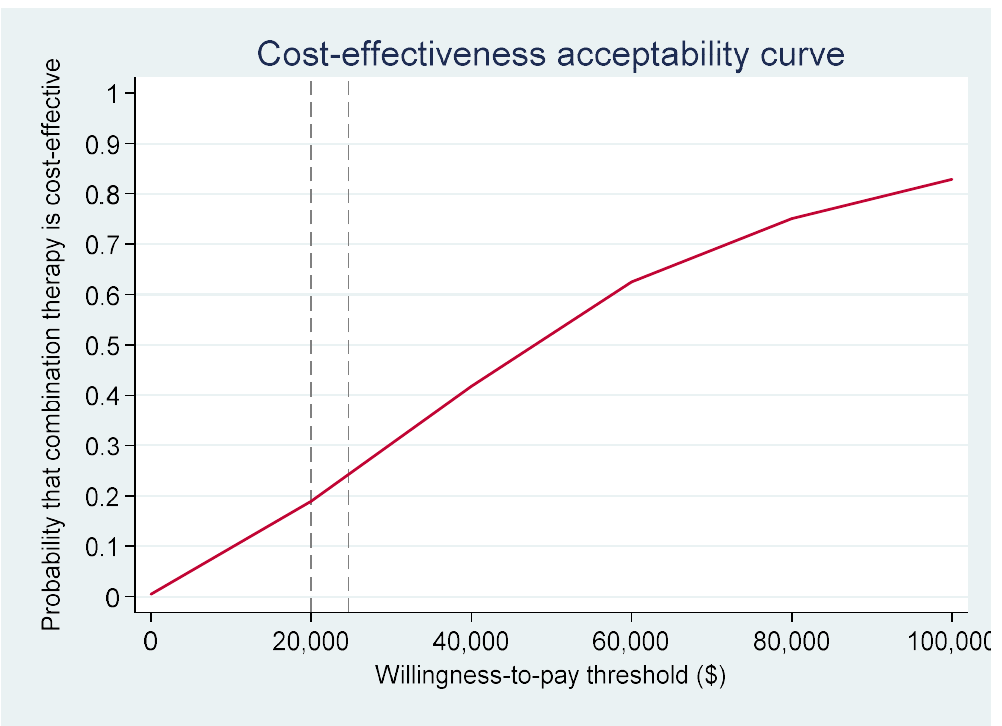
8 of 13 Figure 2. Cost–Effectiveness Plane (societal perspective). Red dot: Incremental cost-effectiveness ratio, Green line: willing- ness-to-pay threshold.